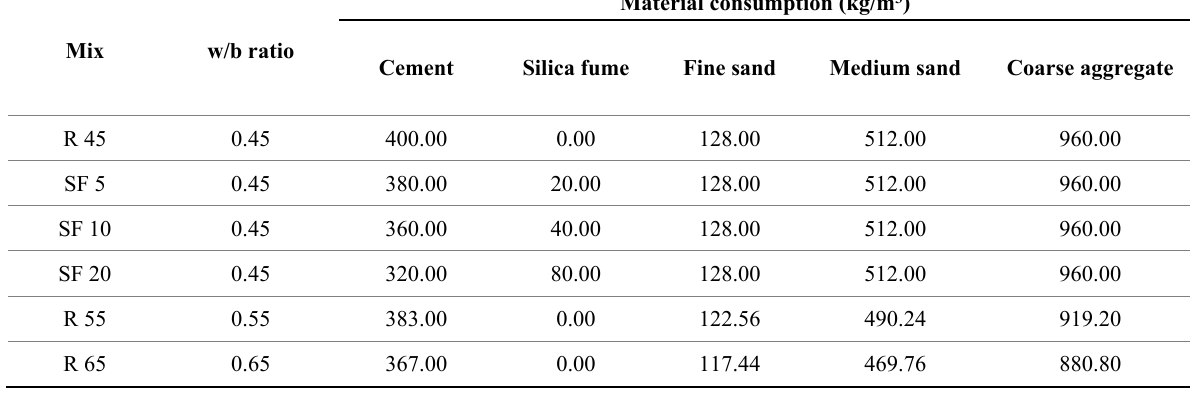
Table 3. Material consumption of the concrete mixes.